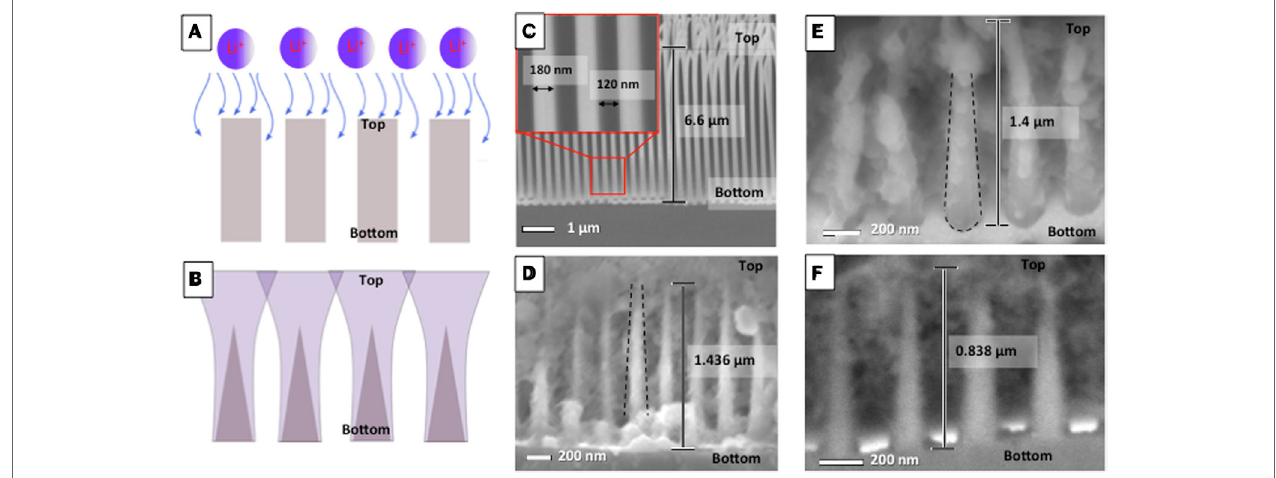
FigUre 2 | (Color online) (a) The schematic illustration of single-crystalline silicon nanowires (SiNWs) with insertion of lithium ions during the electrochemical lithiation. (B) The schematic diagram of SiNWs after lithiation which show that they expand anisotropically and form core–shell structure with two phases—crystalline phase of silicon (shown with dark gray color) and lithiated silicon (amorphous phase of silicon shown with light gray color). (c) Scanning electron microscope (SEM) image of pristine SiNWs, which was taken at a tilt angle of 45 o . After tilt correction, the average height of SiNWs was found to be ~6.604 μ m. The inset shows that the diameter and the space between SiNWs are ~180 and ~120 nm, respectively. (D) SEM image of SiNWs that have gone through lithiation from ~3 to 1 V. The average height of the cone-shaped phase of the SiNWs (which indicates the crystalline core of the lithiated SiNWs) was found to be ~1.436 μ m (after tilt correction). (e) SEM image of SiNWs that have gone through lithiation from ~3 to 0.5 V. After tilt correction, the average height of the cone-shaped phase of the SiNWs was found to be ~1.402 μ m. (F) SEM image of SiNWs lithiated from ~3 to 0.01 V. After tilt correction, the average height of the cone-shaped phase of the SiNWs was found to be ~0.838 μ